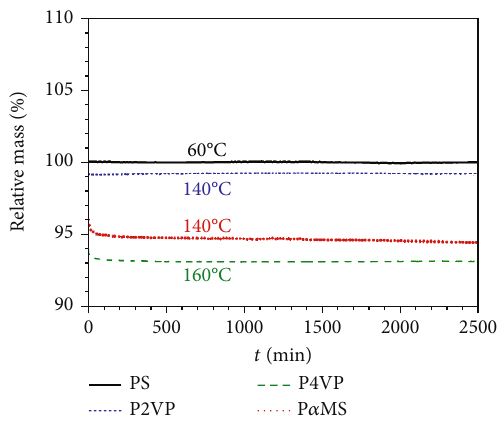
Figure 5: Data of thermal gravimetric analysis at constant temperature in an argon atmosphere. The measurement temperature is indicated.